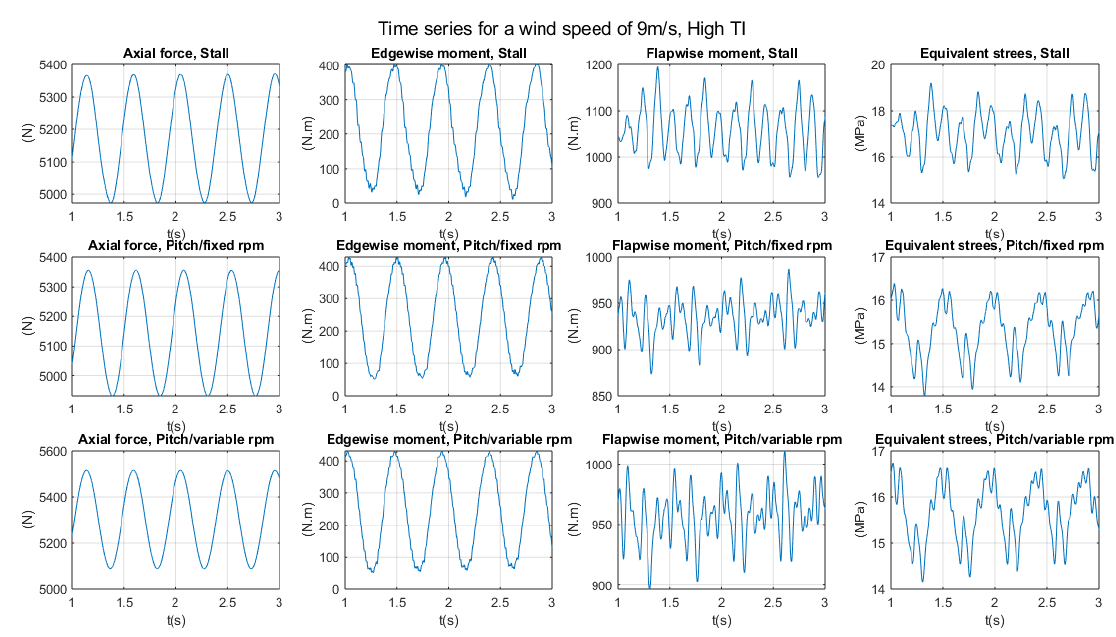
Figure 7. Results of the aeroelastic simulation for an average wind speed of 9 m/s and high turbulence intensity: time